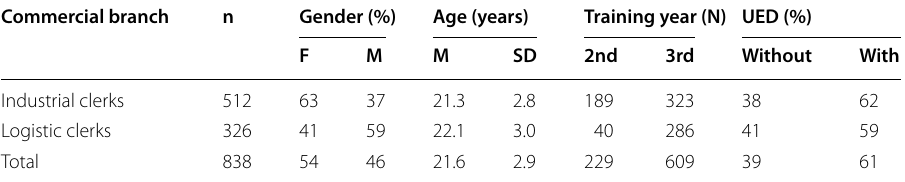
Table 2 Characteristics of the German sample